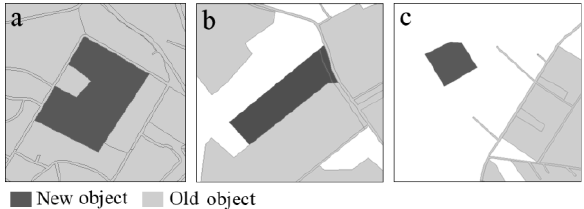
Figure 3. Three growth types: (a) infilling, (b) edge-expansion, and (c)